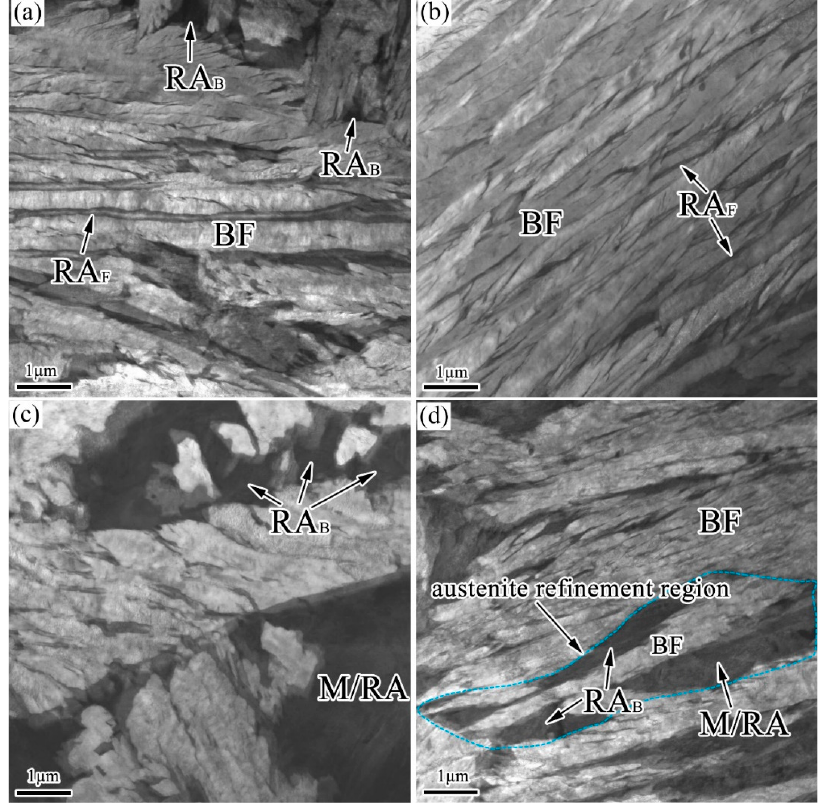
Figure 3. TEM micrographs of the investigated steel for ( a , c ) one-step and ( b , d ) two-step